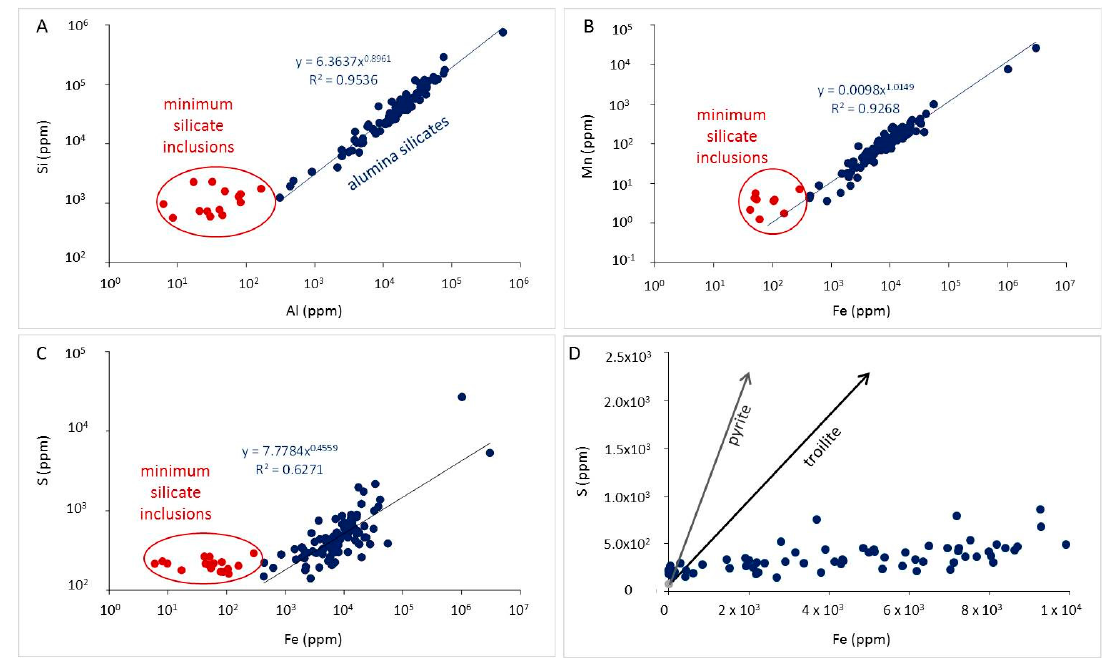
Figure 4. Elemental plots of all data collected in aragonite cement and AcAr crystals with LA-ICP-MS. Correlation of Si and Al, data with minimal contents of Si and Al (i.e., deviation from Si-Al trend) are labeled ( A ); correlation of Mn with Fe ( B ); S-Fe plot ( C ); magnified S-Fe plot ( D ), here arrows show the predicted stoichiometric lines for pyrite and troilite assuming that those minerals are the only sources for Fe and S. Table 2. Elemental ratios of AcAr from rock slabs 6 and 7. Spot # * Mg/Ca S/Ca Sr/Ca